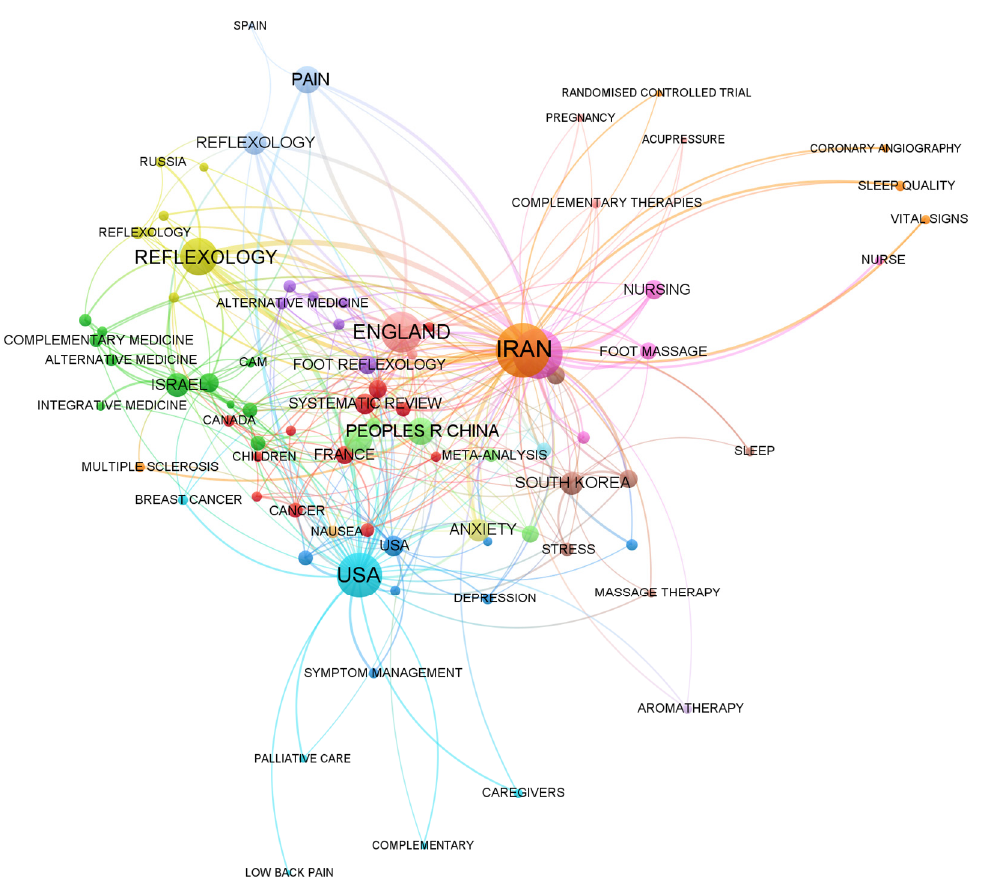
Figure 3. Clusters of similar topics in foot reflexology studies in countries around the world (conditions are calculated with a keyword frequency ≥ 5 and a country frequency ≥ 10).